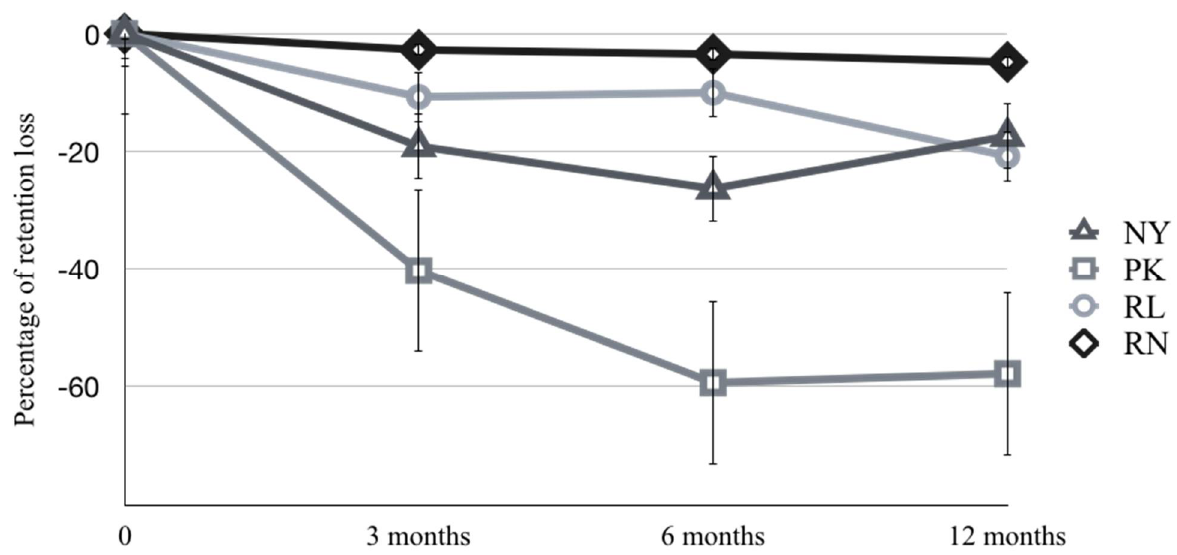
Figure 4. The percentage of retention loss by groups over